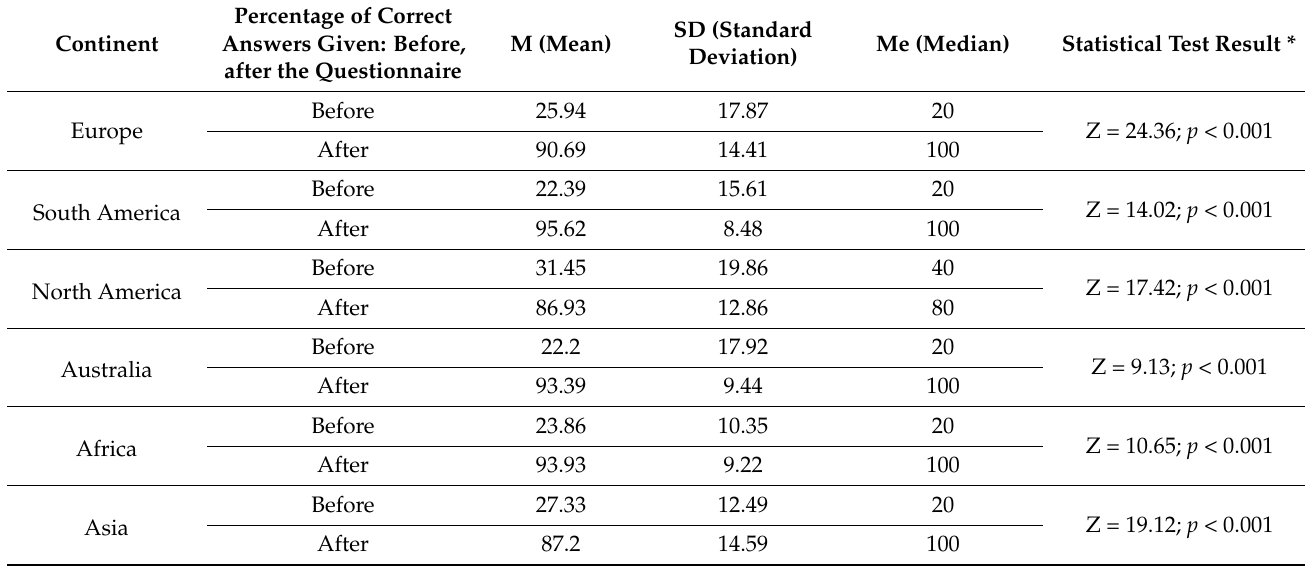
Table 2. Descriptive statistics on the percentage of correct responses given by the study group of psychiatrists from individual continents before and after using the pharmacological interaction database. Continent